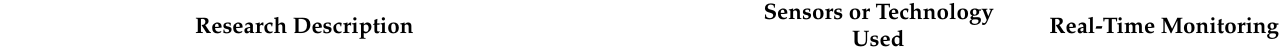
Table 3. Noncommercial/research wearables and sensors for CVD